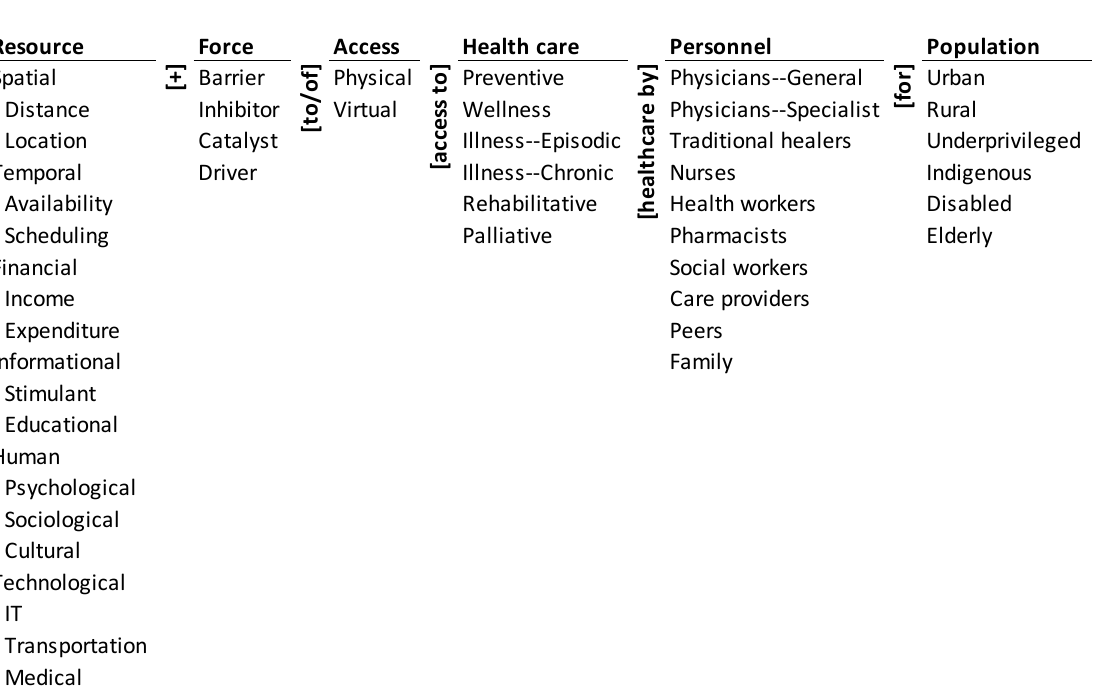
Figure 1. Ontology of access to healthcare during COVID-19. IT: Information Technology.